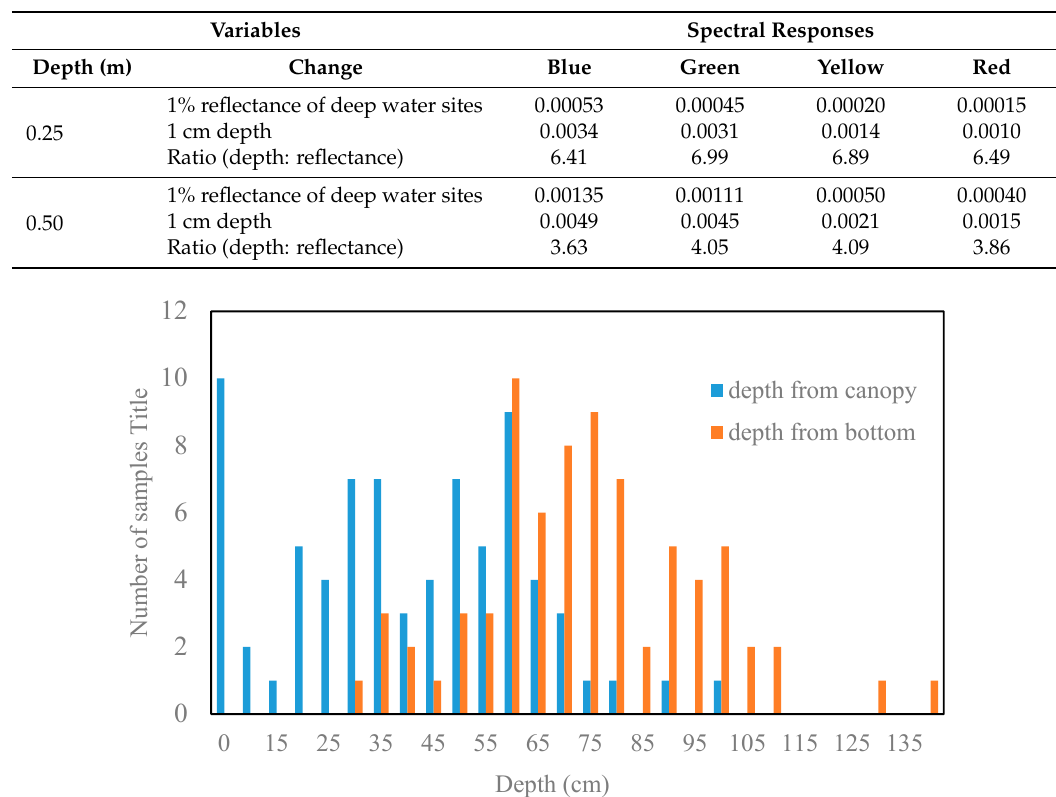
Figure 5. Depth distribution of samples (Red from bottom, blue from canopy).